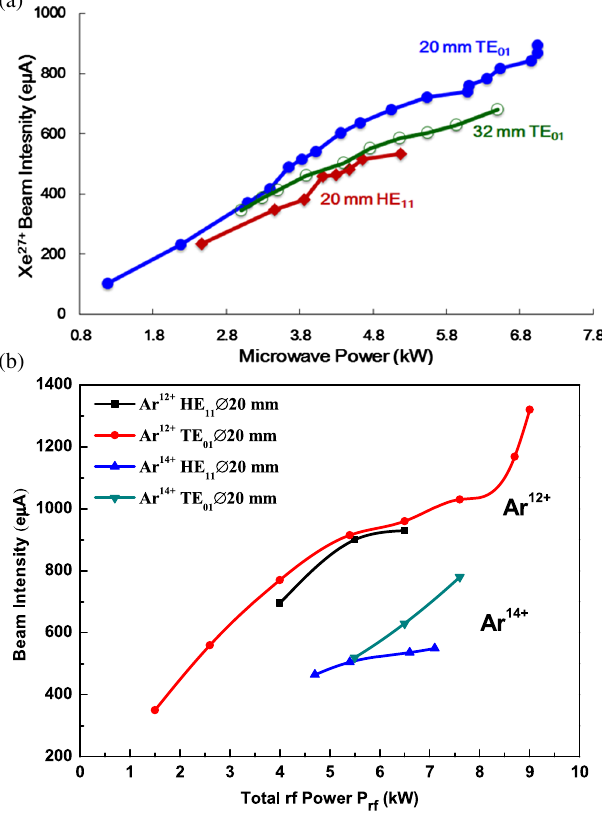
FIG. 17. Dependence of beam intensity on total microwave power at 24 þ 18 GHz coupled at different microwave coupling schemes. (a) 129 Xe 27 þ beam; (b) 40 Ar 12 þ and 40 Ar 14 þ beam.